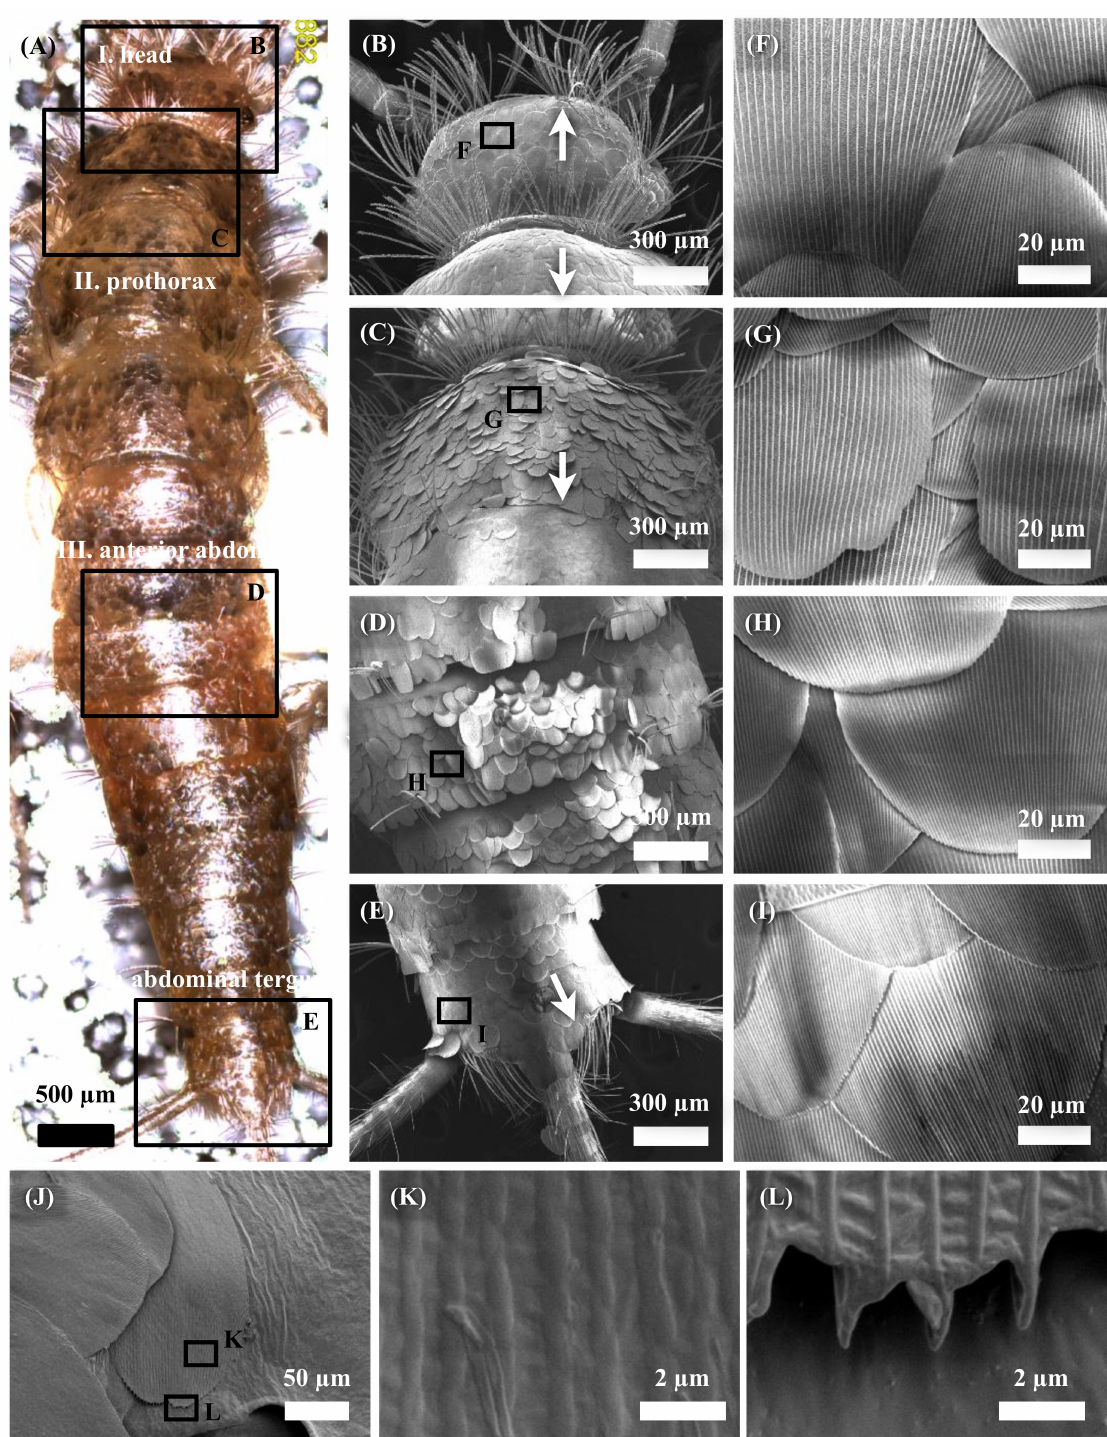
Figure 1. Surface observations of a firebrat by using a light microscope and FE-SEM. ( A ) Light microscopy image of an adult male firebrat. ( B – E ) FE-SEM images of firebrat surfaces for confirming alignments of scales on the firebrat integument: ( B ) head (I); ( C ) prothorax (II); ( D ) anterior abdominal region (III); and ( E ) 9th abdominal tergum (V). White arrows indicate the growth directions of scales. ( F – I ) Higher magnification images from ( B – E ), respectively. ( J – L ) FE-SEM images of backside of the scales. ( K , L ) Higher magnification images from ( J